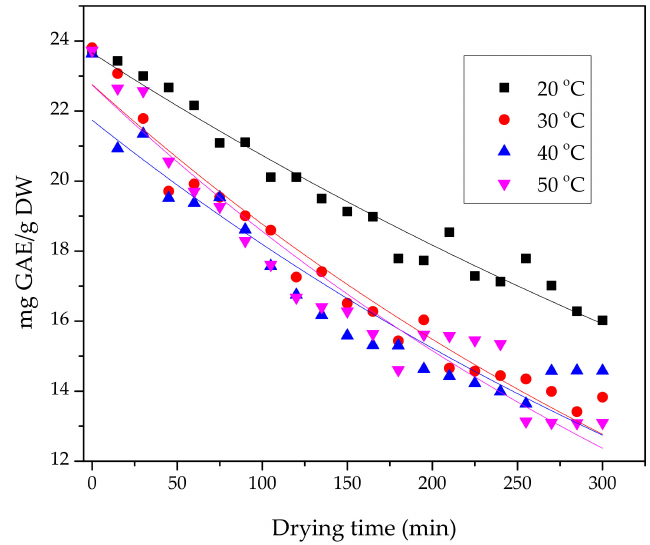
Figure 6. The first–order kinetic model of polyphenols in the heat pump drying